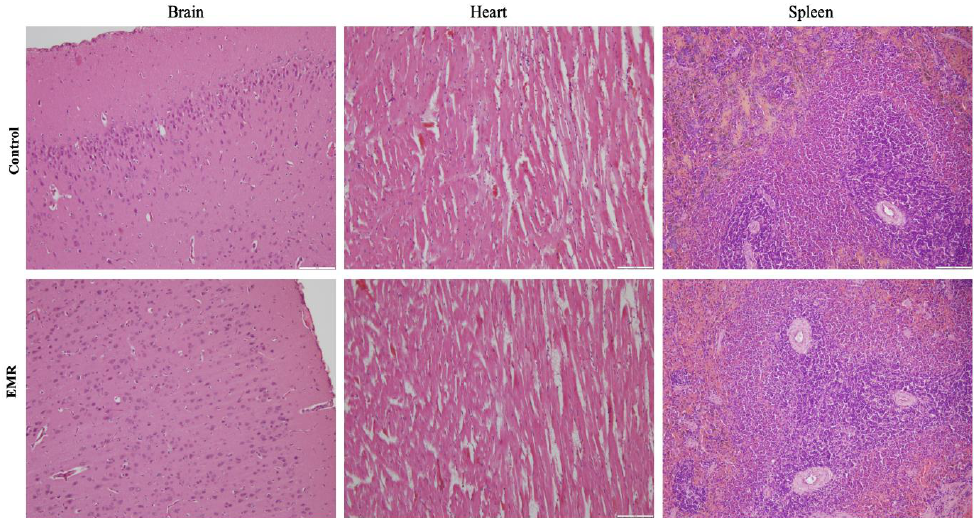
Figure 5. The effect of 150 kHz IF EMR on the histopathology of brain, heart, and spleen of rats in the control and EMR groups after 2 months of whole-body exposure. In the brain, glial cells and typical neuronal architecture were visible. In the myocardium, normal myocardial fibres could be detected. In the spleen, there were sinusoids and typical lymphoid follicles. (H&E × 200).